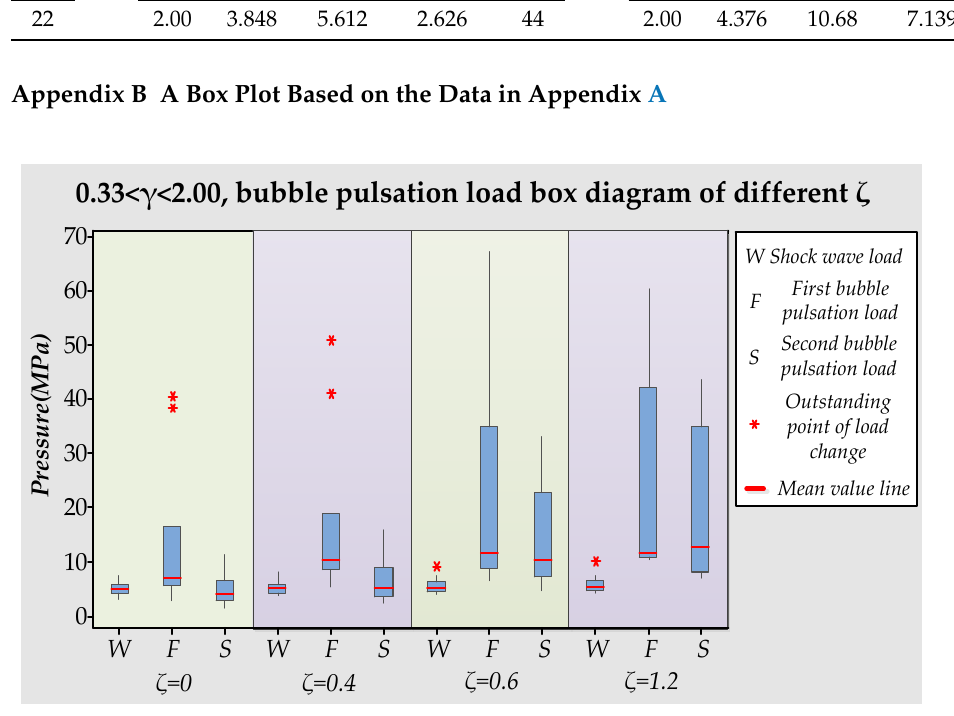
Figure A1. A box plot based on the data in Appendix A.